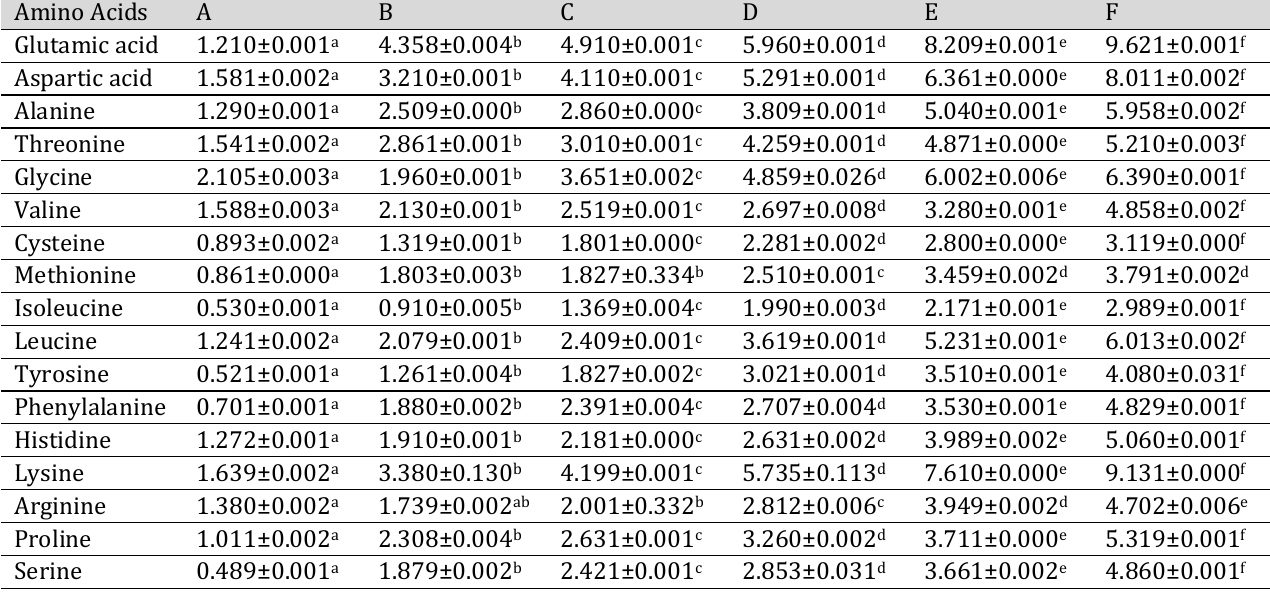
Table 6. Amino acid composition of fermented extruded blends of Cassava-African yam bean (g/100g).